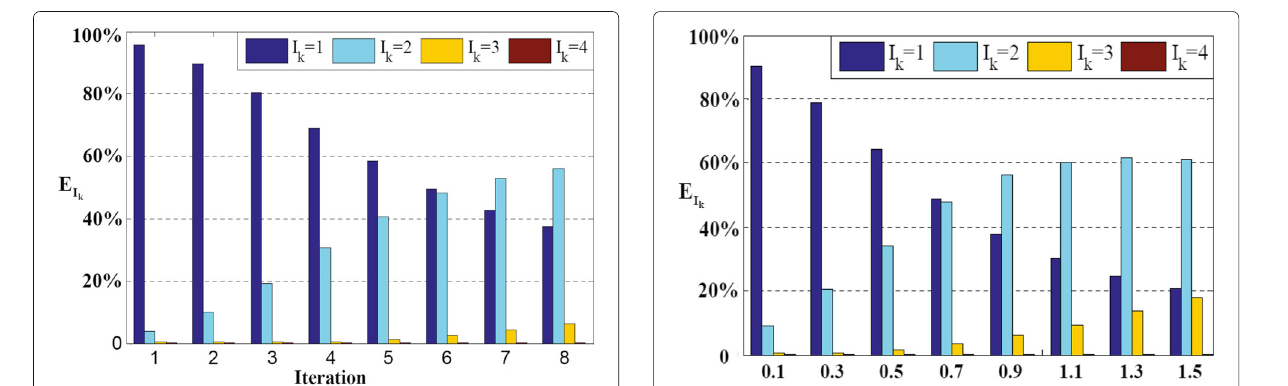
Fig. 4 Statistical distribution of E I iteration number true, which means the difference between α (cid:5) k {